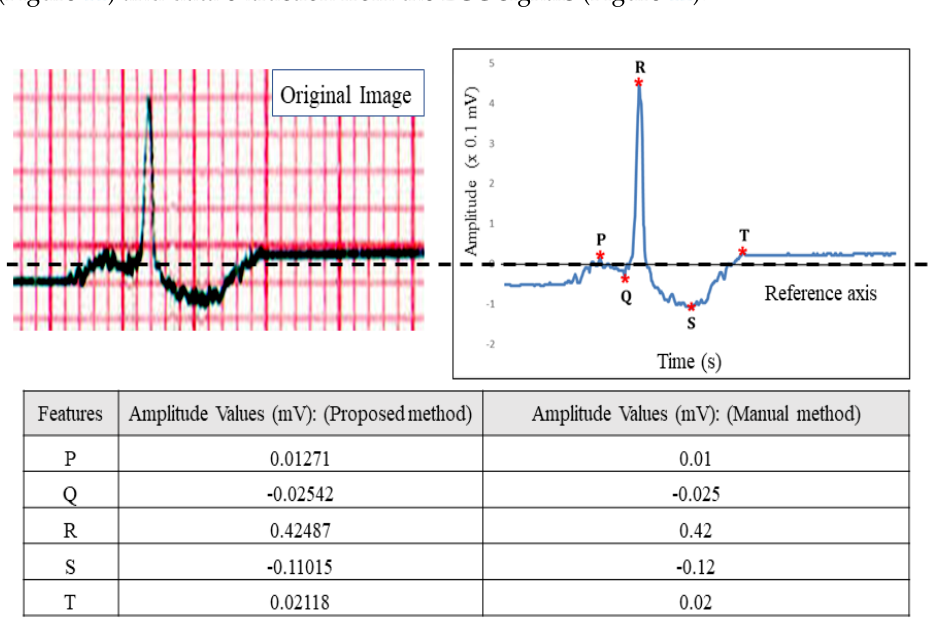
Figure 11. Comparison of features of the ECG sample and digitized ECG for the sample data.